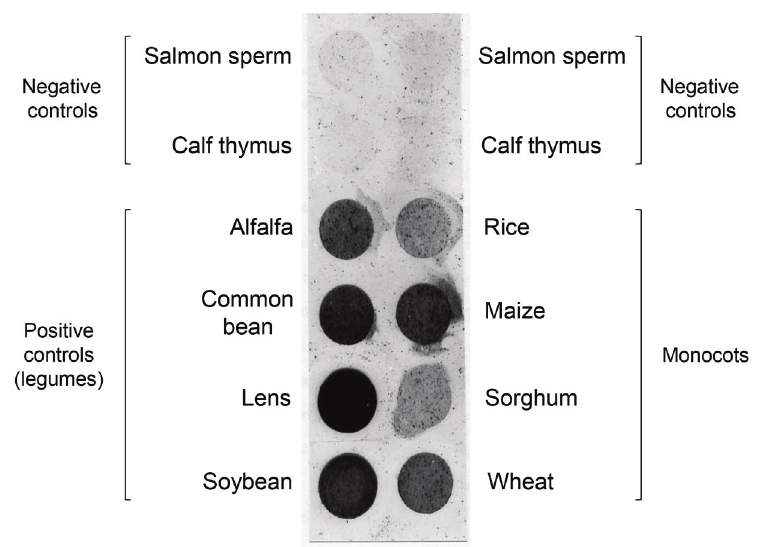
Figure 1. Early (1991) detection of rice, maize, sorghum and wheat hb -like sequences by dot-blot hybridization (R. Arredondo-Peter, unpublished results). Approximately 20 μg of undigested total DNA was used as template and a consensus oligonucleotide for legume and non-legume plant Hbs 58 was used as probe. Sequence of the consensus probe was 5´-GTA GCC TAT GAT GAA TTG GCA GCT GCA ATT AAG-3´. The probe was labeled by nick translation with Biotin-dATP using a Bionick labeling system (Gibco BRL). The membrane was prehybridized with SSC 2× for 4h at 42°C, hybridized overnight at the same temperature, washed at high stringency (SSC 2×/SDS 0.1% for 3 min at room temperature, SSC 0.2×/SDS 0.1% for 15 min at room temperature and SSC 0.16×/SDS 0.1% for 15 min at 65°C) and incubated with the streptavidin-alkaline phosphatase conjugate and the BCIP/NBT mix to develop color. Animal (salmon sperm and calf thymus) and legume DNAs were included as negative and positive controls,